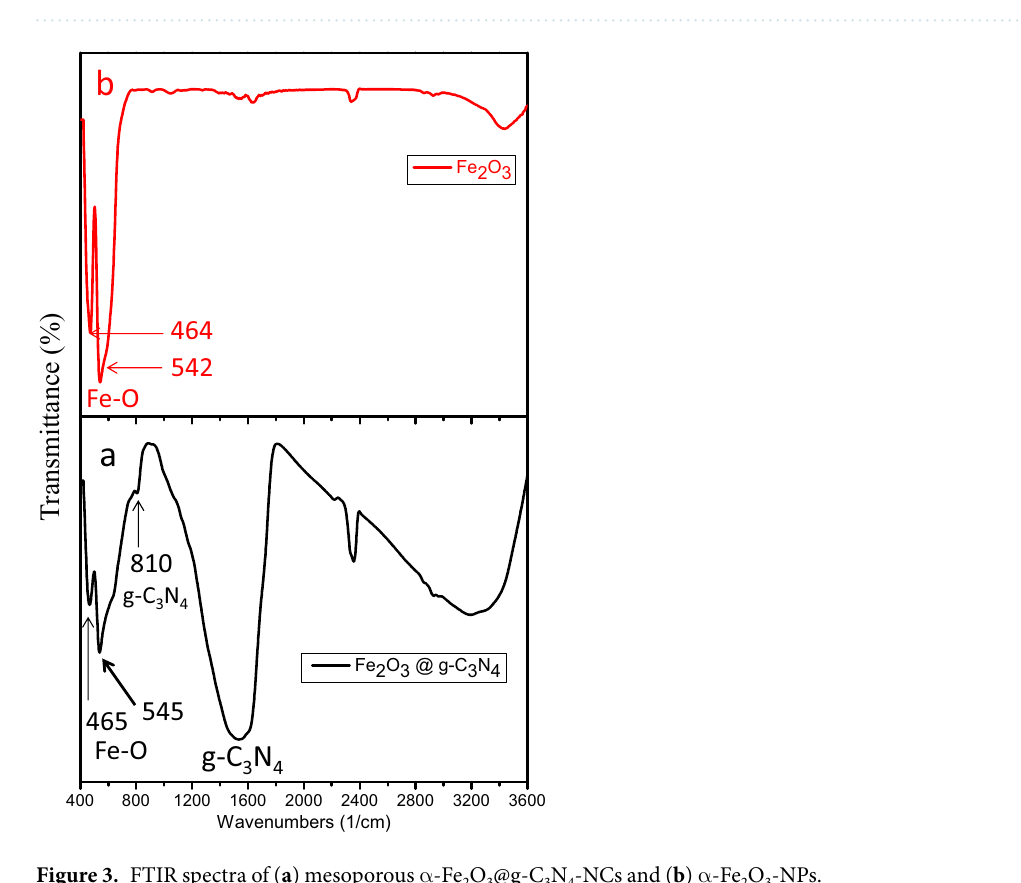
Figure 3. FTIR spectra of ( a ) mesoporous α -Fe 2 O 3 @g-C 3 N 4 -NCs and ( b ) α -Fe 2 O 3